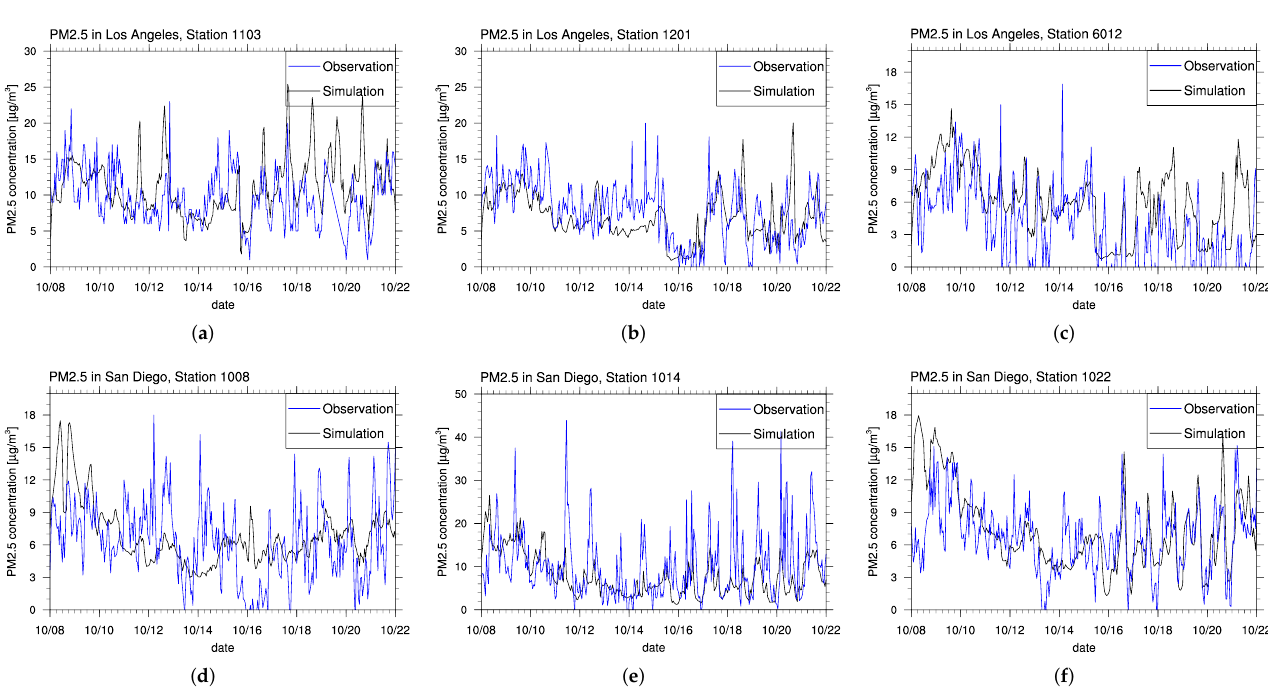
Figure 16. Comparison of in situ measurements with modeled PM2.5 at the ground at Los Angeles North Main Street ( a ), Reseda ( b ), Santa Clarita ( c ), Camp Pendleton ( d ), Donovan ( e ), and El Cajon, Lexington Elementary School ( f ) in October